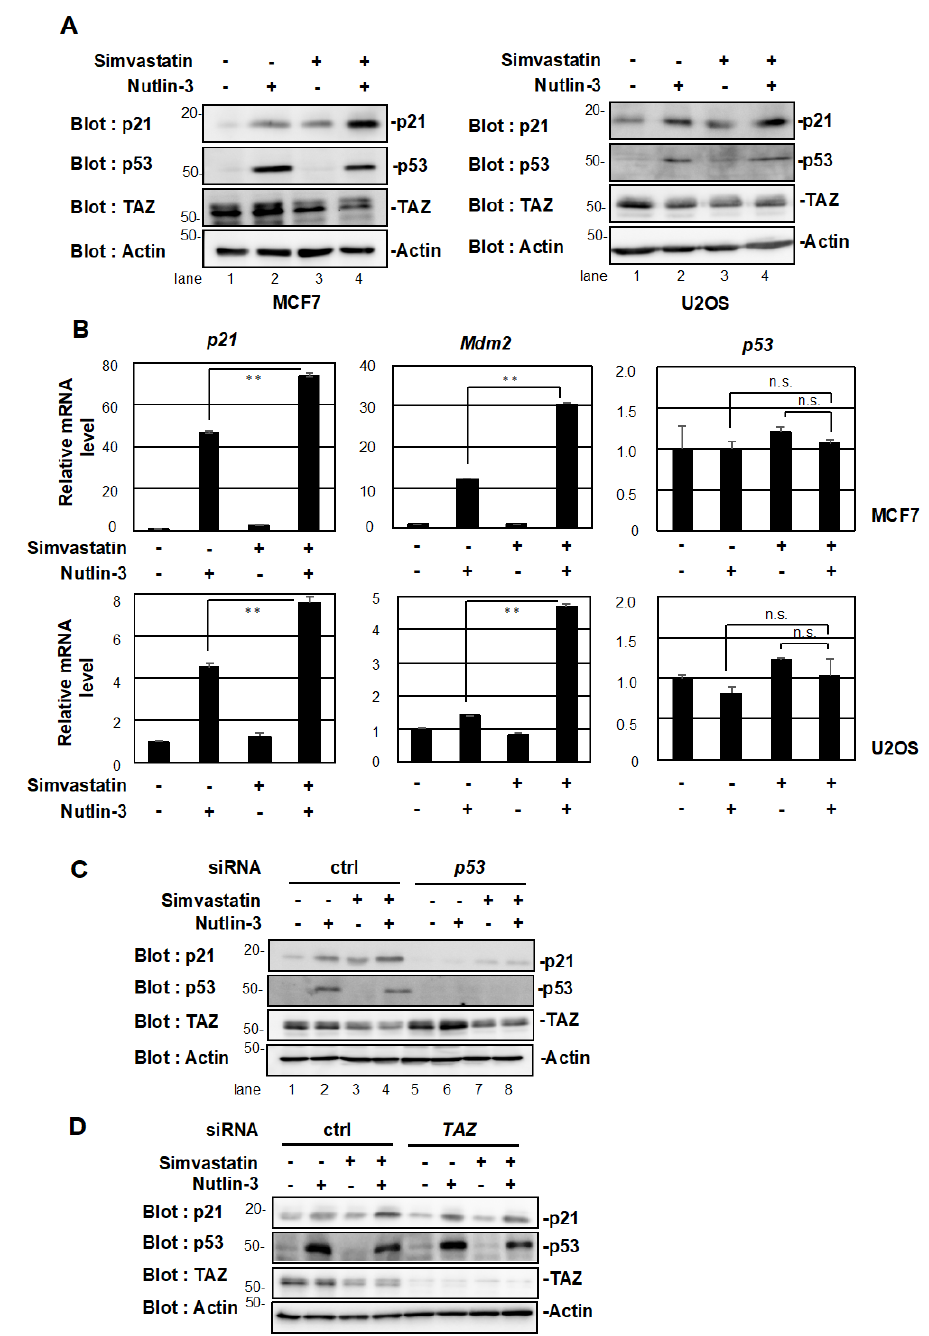
Figure 3. Simvastatin enhanced p53 target gene expression. ( A ) MCF7 and U2OS cells were pretreated with 10 µ M simvastatin for 24 h. Cells were then incubated with 10 µ M nutlin-3 for 4 h. Cell lysates were analyzed by Western blotting with the indicated antibodies. ( B ) MCF7 and U2OS cells were pretreated with 10 µ M simvastatin for 24 h. Cells were then incubated with 10 µ M nutlin-3 for 4 h. The expression of each gene was assessed using qPCR. The expression levels of each mRNA were normalized using the expression level of β -actin mRNA. Data represent the mean ± S.D. ( n = 3). Significant differences are indicated as ** p < 0.01, n.s., not significant. ( C ) MCF7 cells were transiently transfected with control or p53 siRNA. The cells were treated with 10 µ M simvastatin for 24 h and then incubated with 10 µ M nutlin-3 for 4 h. Cell lysates were analyzed as in ( A ). ( D ) MCF7 cells were transiently transfected with control or TAZ siRNA. The cells were treated with 10 µ M simvastatin for 24 h and were then incubated with 10 µ M nutlin-3 for 4 h. Cell lysates were analyzed as in ( A ).